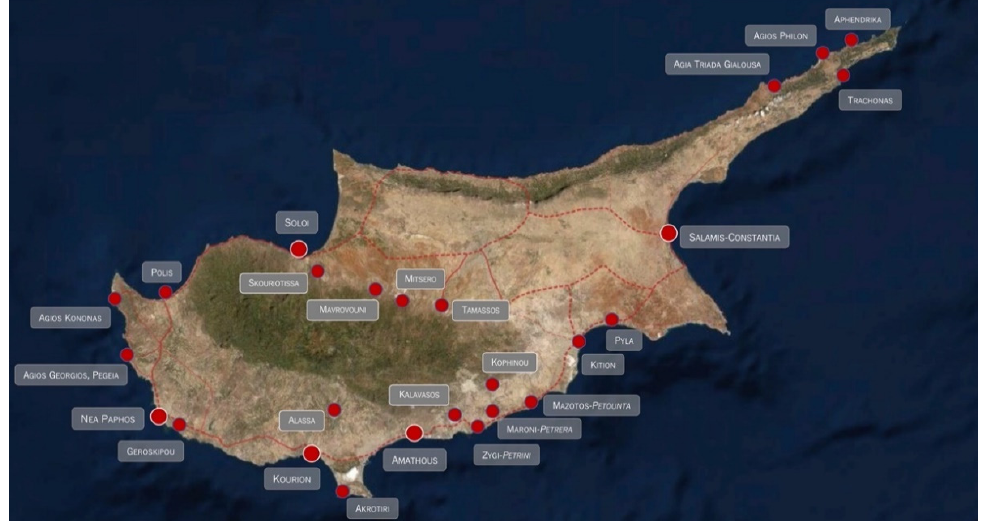
Figure 1. Map of Cyprus and late Roman road network (Dig-TIB, ÖAW, © ESRI, adapted from Ancient World Mapping Center).